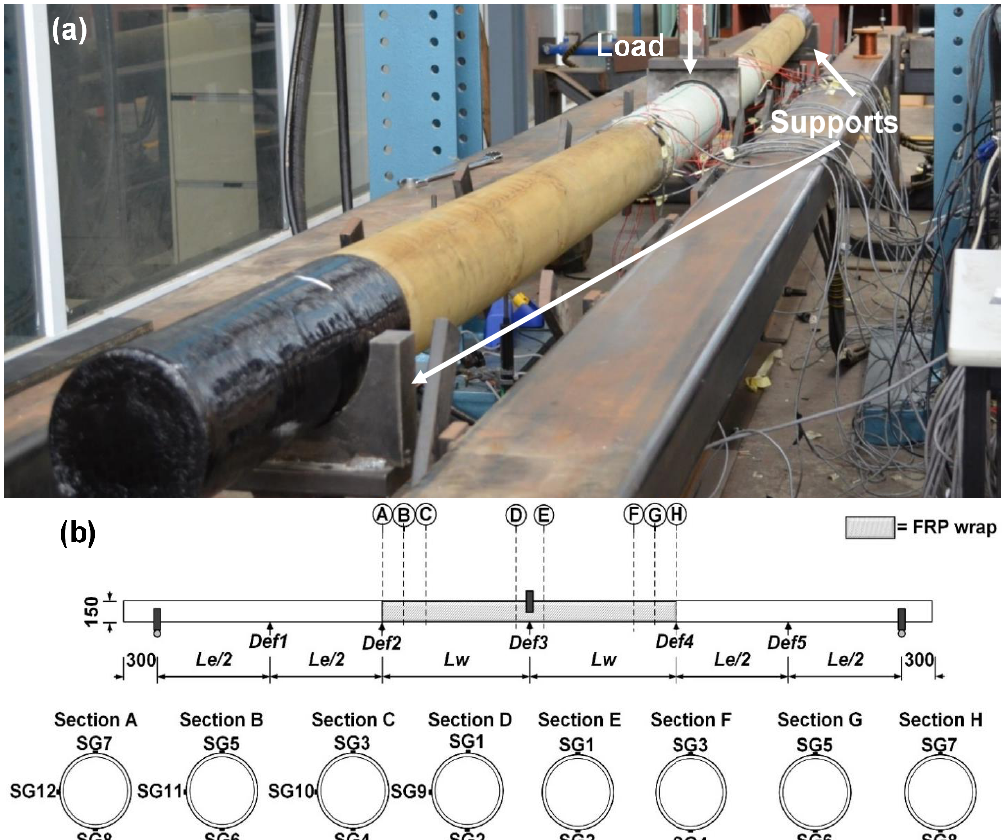
Figure 4. ( a ) Experimental setup of specimens (TWE30 as an example) and ( b ) strain gauge and LVDTs instrumentation for all